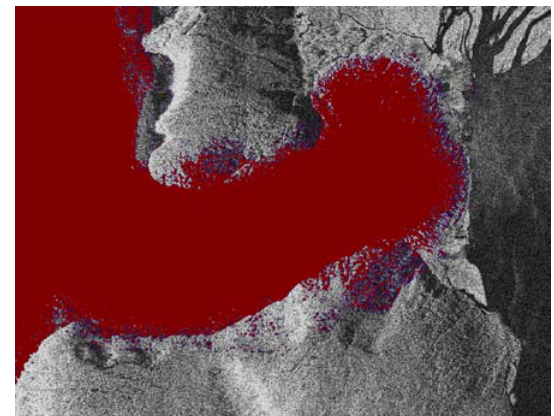
Fig. 10. The glacier surface classification result (red colour) plotted on the geo-coded gray scale SAR scene.